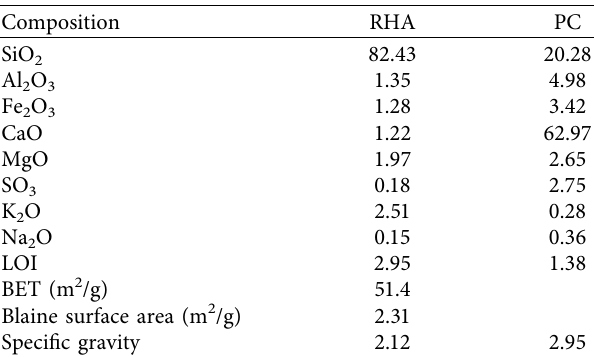
Table 1: Composition and physical properties of RHA and PC.